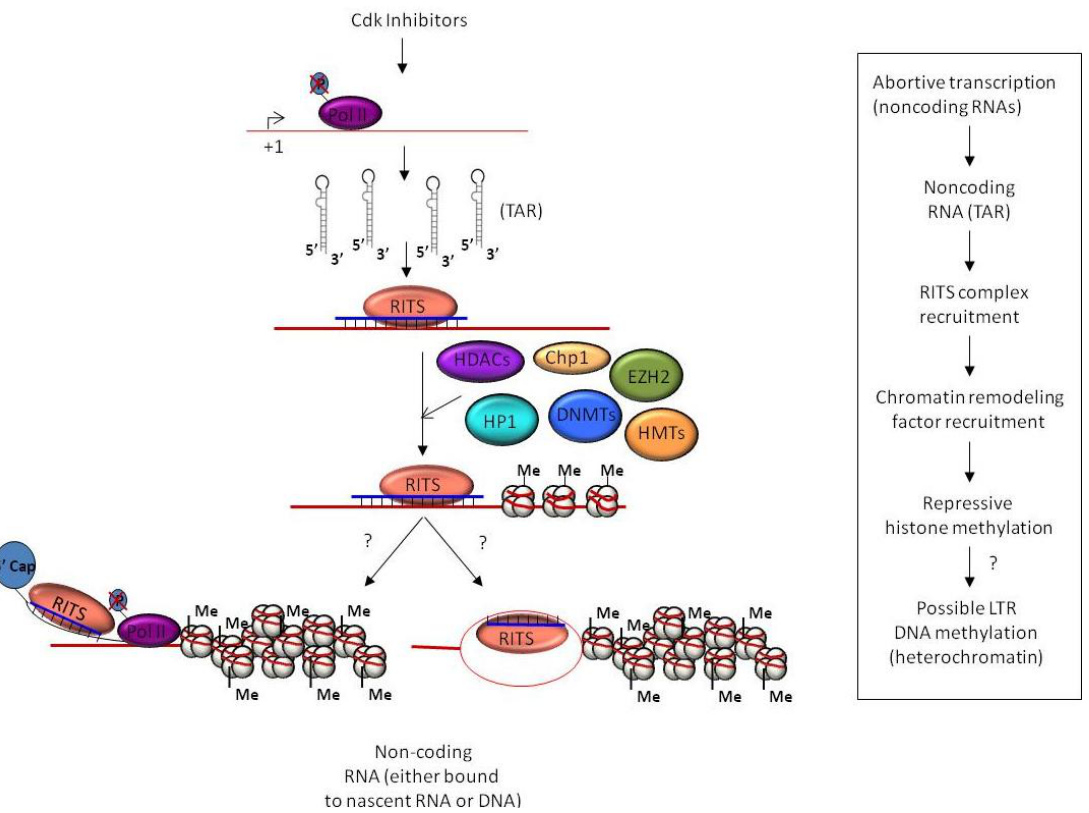
Figure 2. Pol II with hypo-phosphorylated C-terminal domains (CTDs) leads to